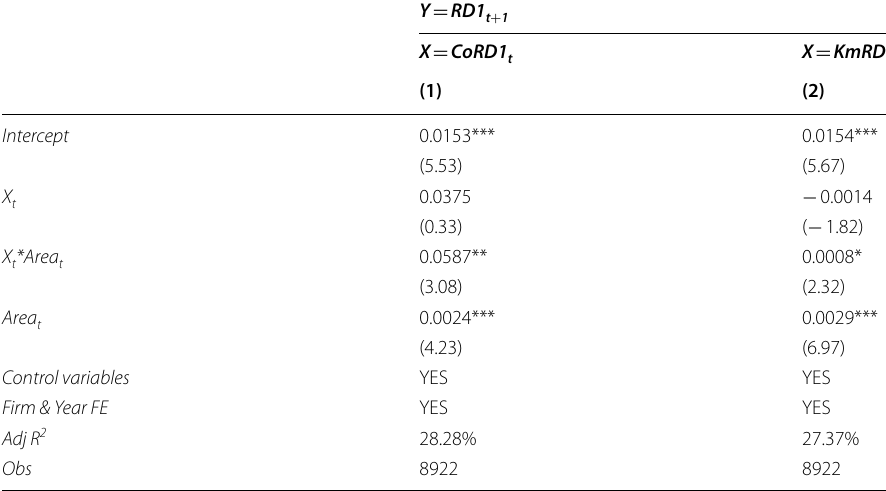
Table 8 Influence of highly developed regions on learning efficiency